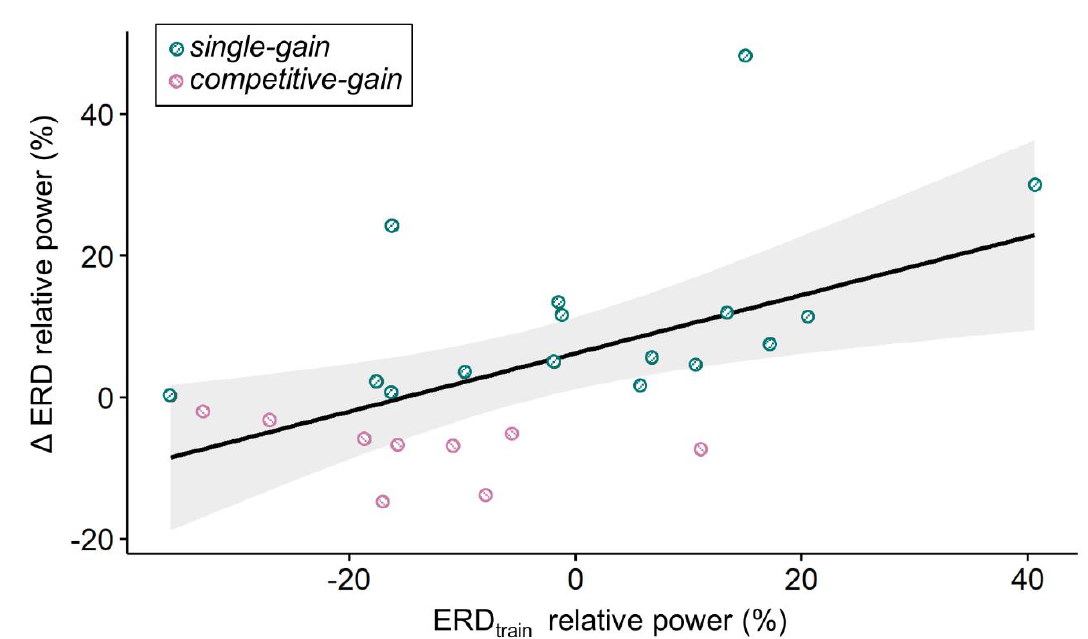
Figure 4. Visualization of the multiple linear regression result. Scatter plot of ∆ ERD and ERDtrain depicted as relative power (%). Participants with a negative ∆ ERD had a stronger relative ERD in the competitive multi-user condition compared to the single condition (group competitive-gain in pink); participants with a positive ∆ ERD had a stronger relative ERD in the single condition compared to the competitive multi-user condition (group competitive-gain in azure). The black line corresponds to the regression line of the significant regression equation with ERDtrain as the single predictor (see text for details). The grey area indicates the 95% confidence